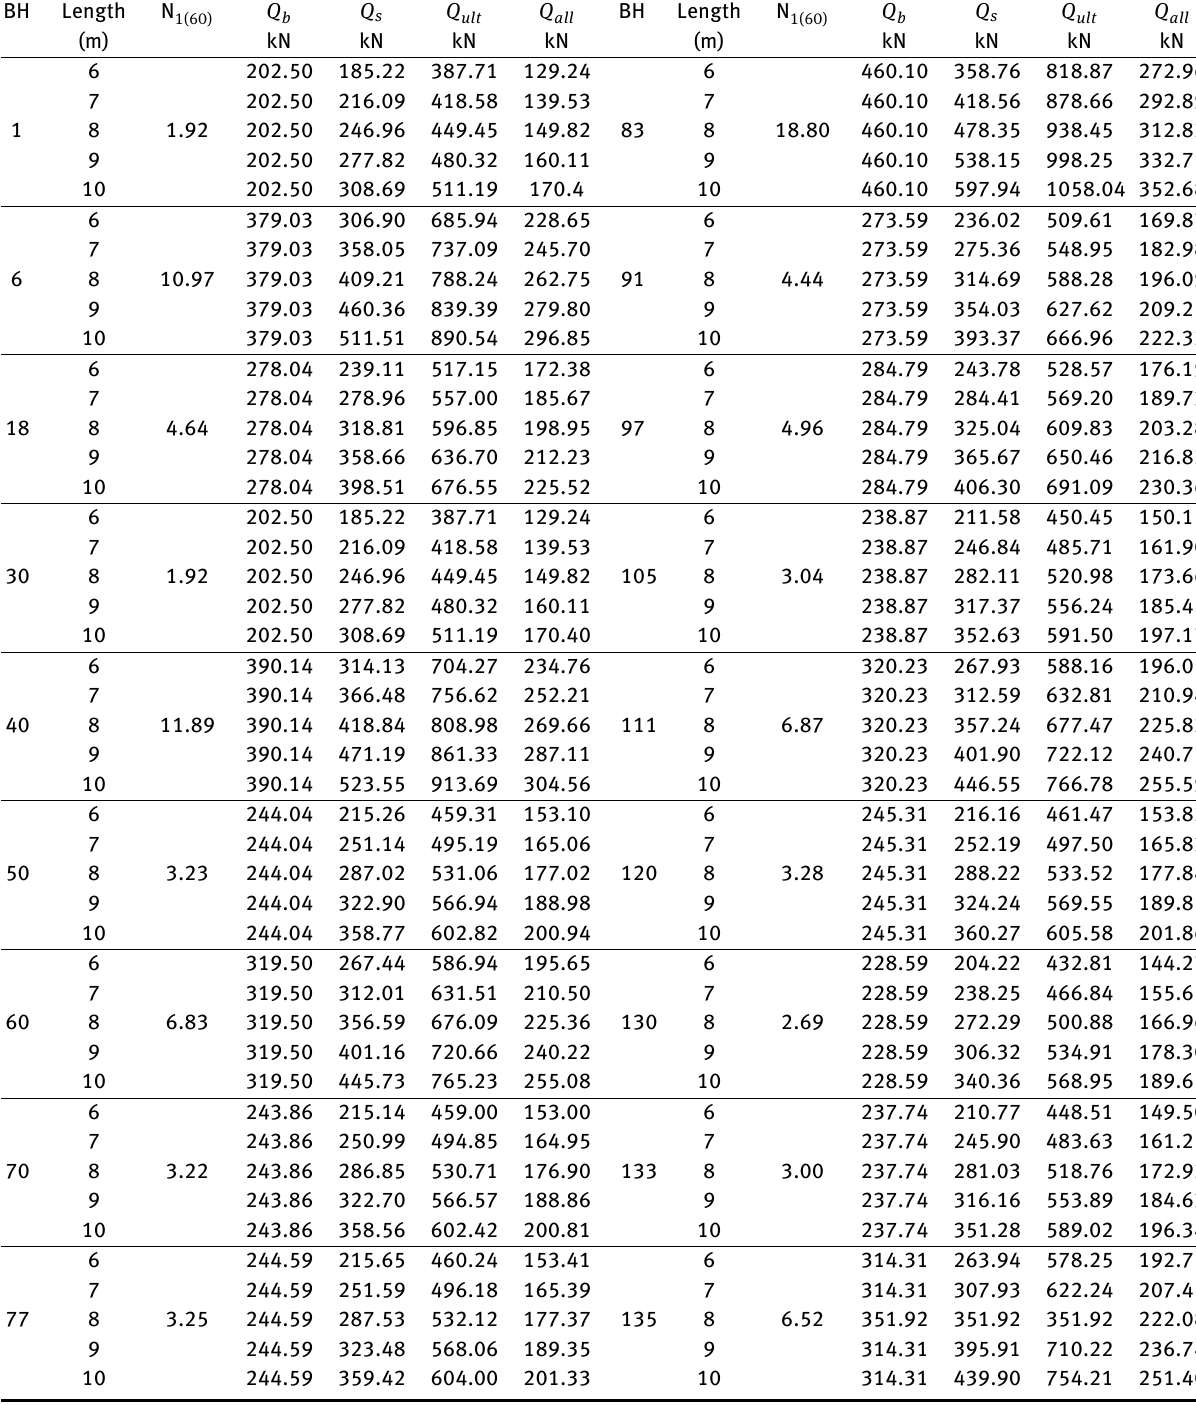
Table 2: Corrected SPT values and allowable bearing capacity of driven piles